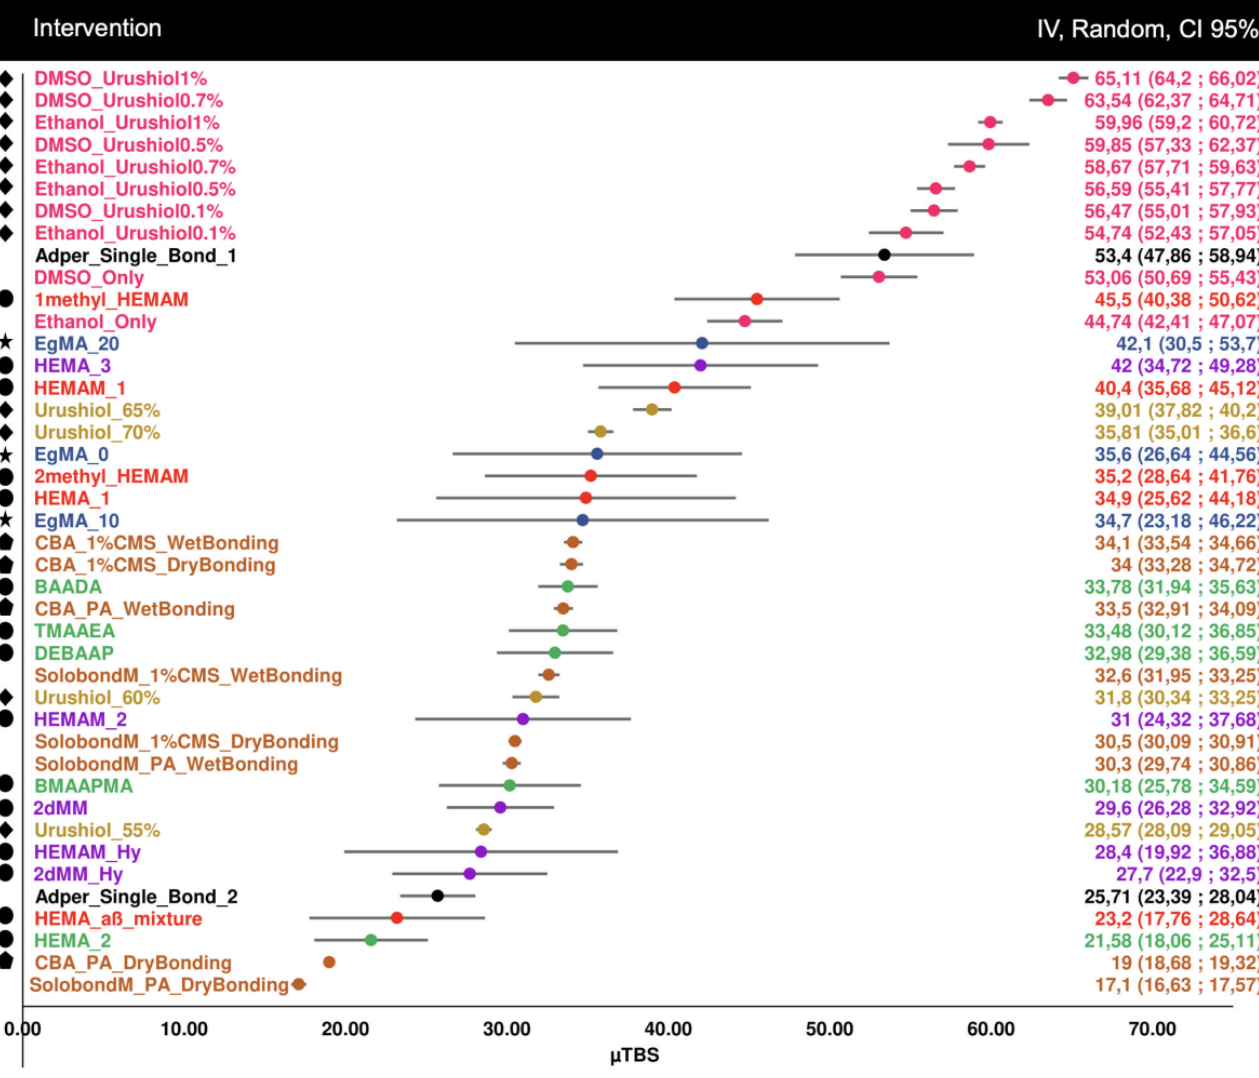
Figure 2. Forest plot of the immediate microtensile bond strength, including 7 distinct studies with different strategies and 3 commercial controls, which do not have any symbol, purposefully—Adper Single Bond 1, Adper Single Bond 2 and Solobond M. Symbol legend: ★ eugenyl methacrylate de- rivatives; ● methacrylamide derivatives; ◆ urushiol derivatives; ⬟ CBA monomer derivatives.